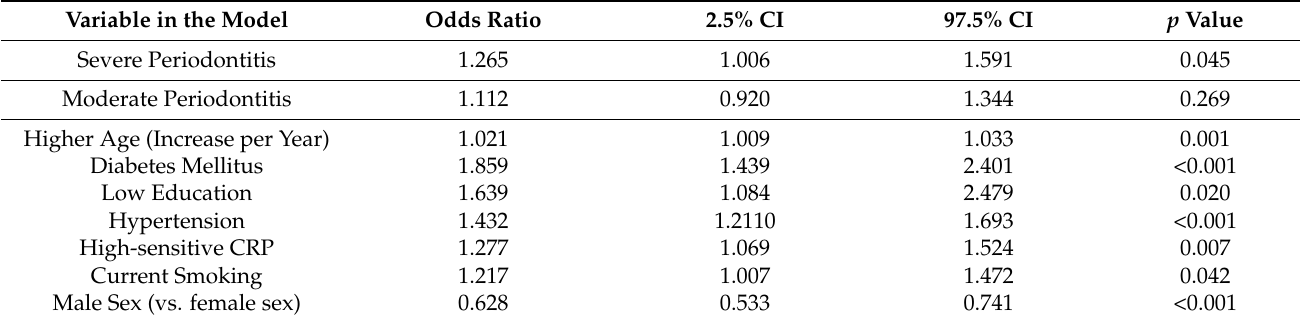
Table 2. Logistic regression model of variables significantly associated with a peripheral arterial occlusive disease in participants included in the Hamburg City Health